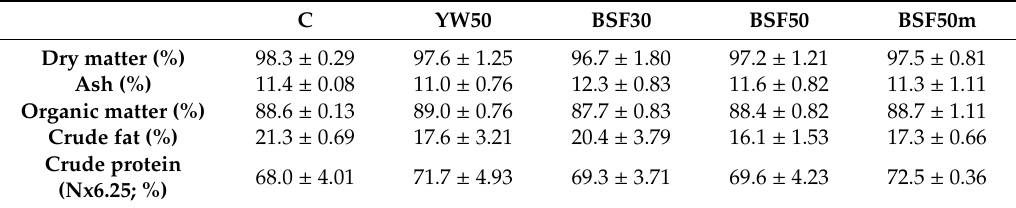
Table 2. Proximal composition of fillet of D. labrax fed di ff erent experimental diets ( n = 6). C